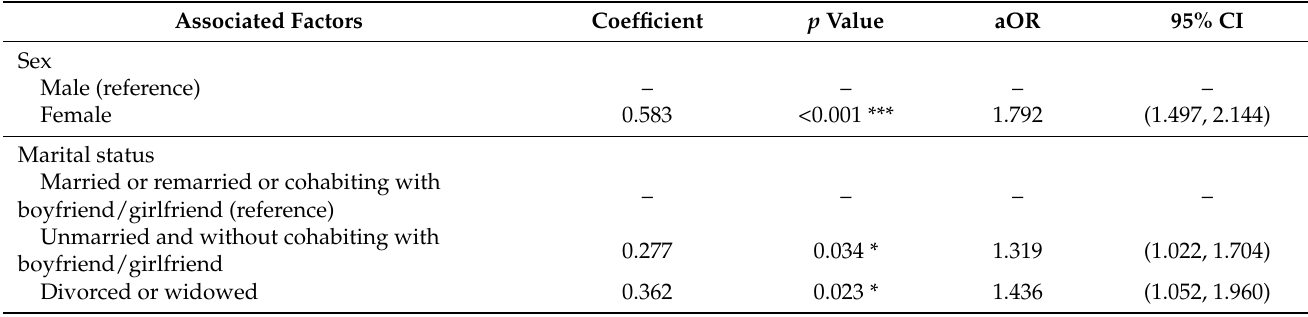
Table 3. Associated Factors of Sleep